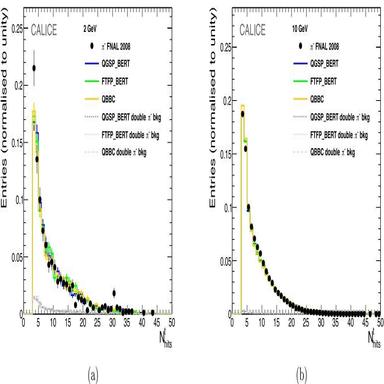
Number of hits per reconstructed track for energies of 2 GeV (a) and 10 GeV (b) of the beam energy. Other details follow those of